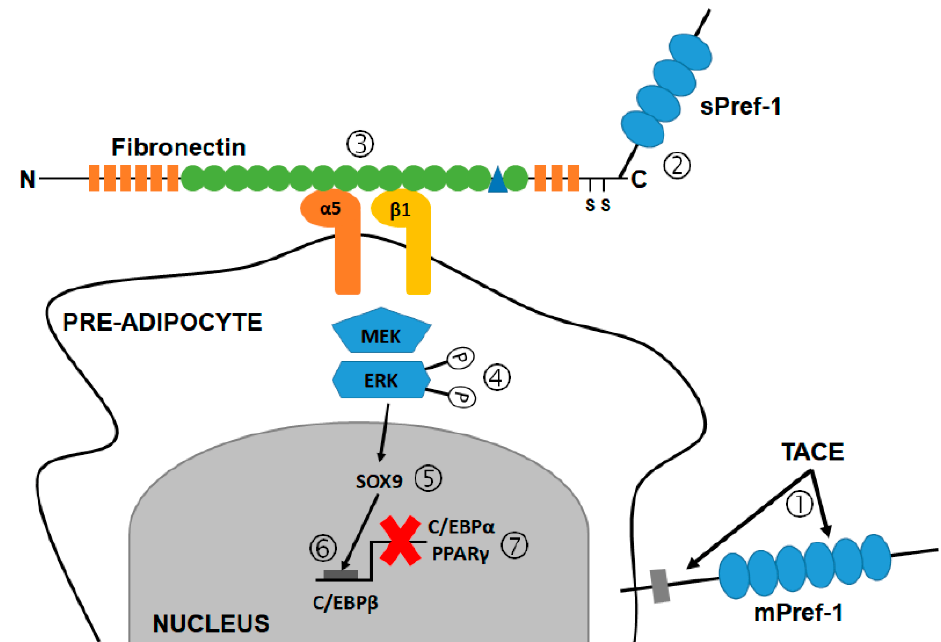
Figure 7. Schematic illustration of the suggested mechanism of Pref-1-mediated inhibition of adipogenesis involving the MEK / ERK pathway. (1) TACE-mediated cleavage of membrane bound Pref-1. (2) 50 kDA soluble Pref-1 binds to the C-terminus of fibronectin. (3) Fibronectin binds to the α 5 β 1 integrin receptor and the fibronectin / sPref-1 complex (4) activates the MEK / ERK pathway, which in turn (5) activates SOX9. (6) SOX9 binds to the C / EBP β promoter, preventing up-regulation of C / EBP β and (7) consequently up-regulation of C / EBP α and PPAR γ . Figure adapted by C.D. from Hudak and Sul (2013) [100]. C / EBP α , CAAT-enhancer binding protein alpha; C / EBP β , CAAT-enhancer binding protein beta; ERK, Extracellular signal-regulated kinases; MEK, Mitogen-activated protein kinase kinase; mPref-1, membrane-bound preadipocyte factor-1; sPref-1, soluble preadipocyte factor-1; PPAR γ , Peroxisome proliferator-activated receptor gamma; TACE, Tumor necrosis factor alpha converting enzyme.